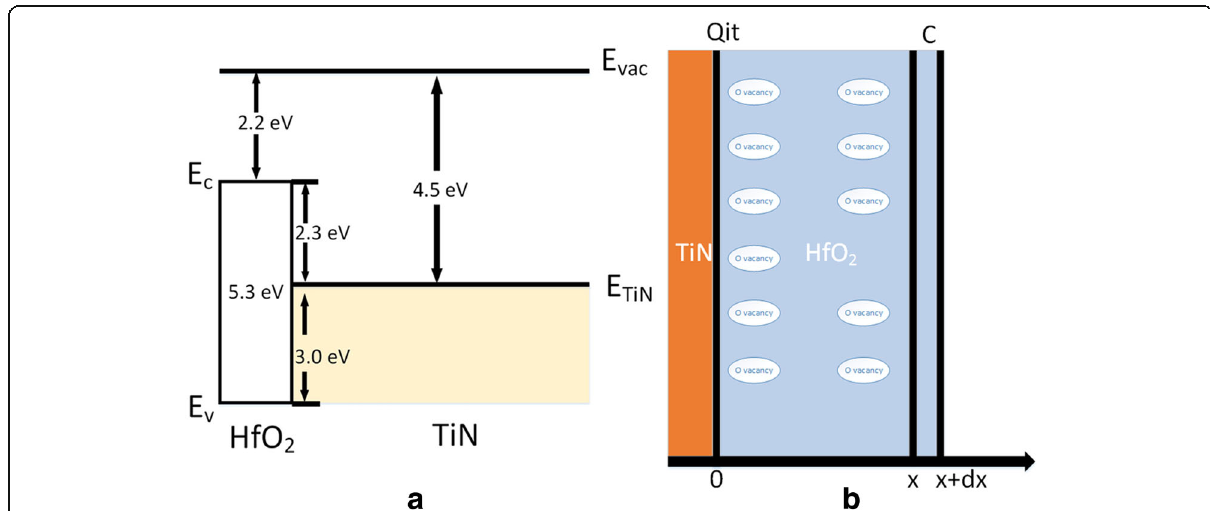
Fig. 4 Band alignment and structure. a Band alignment of HfO 2 /TiN structure was measured by the UPS and SE measurement. b Structure of TiN/